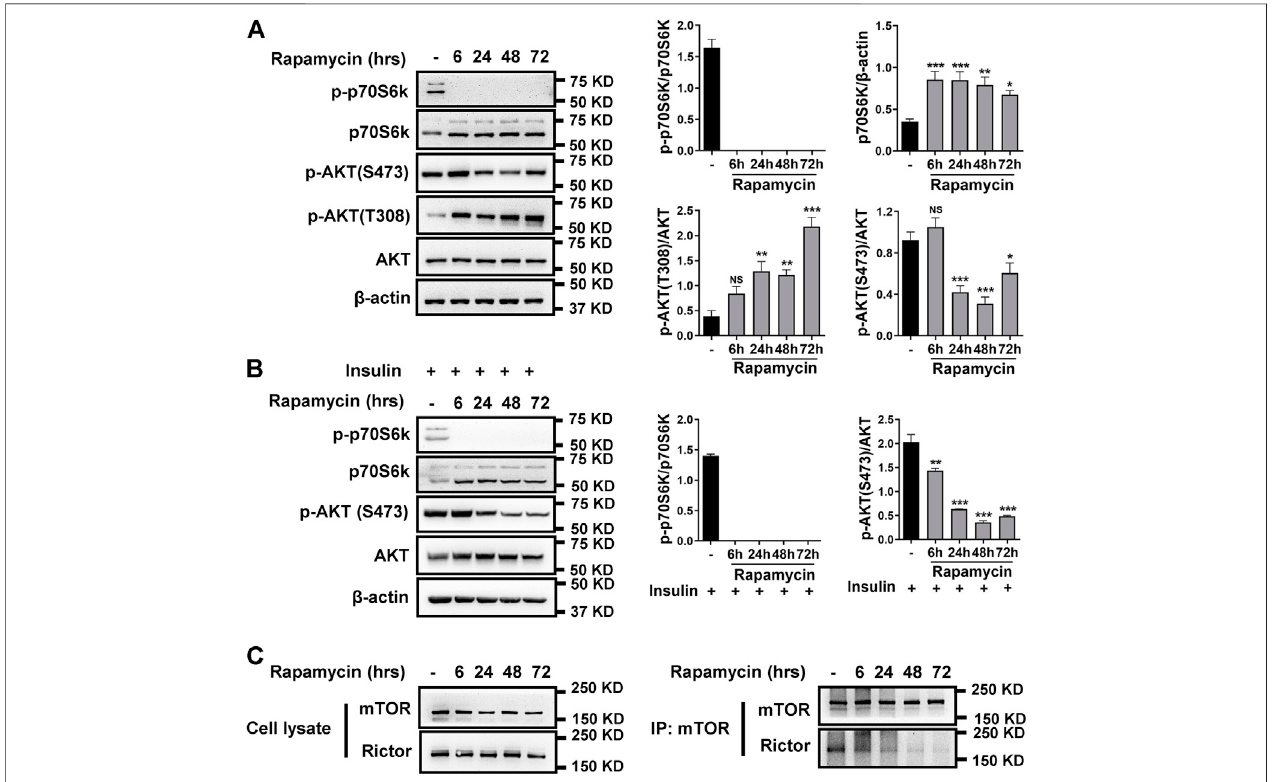
FIGURE 1 | Rapamycin inhibits mTORC1 and mTORC2. (A) hPASMCs were treated with 100 nM rapamycin for the indicated times and analyzed by immunoblotting for the proteins level of p-p70S6k, p70S6k, p-AKT (S473), p-AKT (T308), AKT. (B) immunoblotting analyses of p-p70S6k, p70S6k, p-AKT (S473), and AKT in hPASMCs, which were stimulated with 5 μ g/ml insulin for 24h before treatment with 100 nM rapamycin. (C) hPASMCs were treated with 100 nM rapamycin for theindicatedtimes,andthencelllysateswerepreparedforandimmunoprecipitation(IP)withmTORantibody.TheelutionfromIPwasanalyzedbyimmunoblotting forthelevelsofmTORandRictor.Dataarepresented asthemean ± SE.One-wayANOVAwasused forstatisticalanalysis.NSmeansnotsigni fi cant.*** p < 0.001;** p < 0.01; * p < 0.05 versus control.